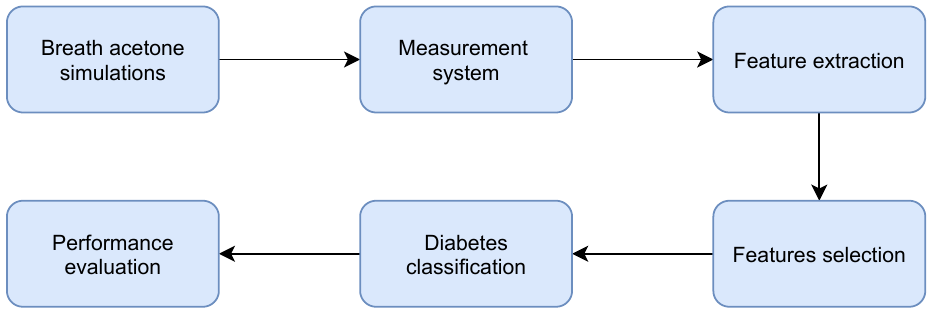
Figure 2. Block scheme of the proposed